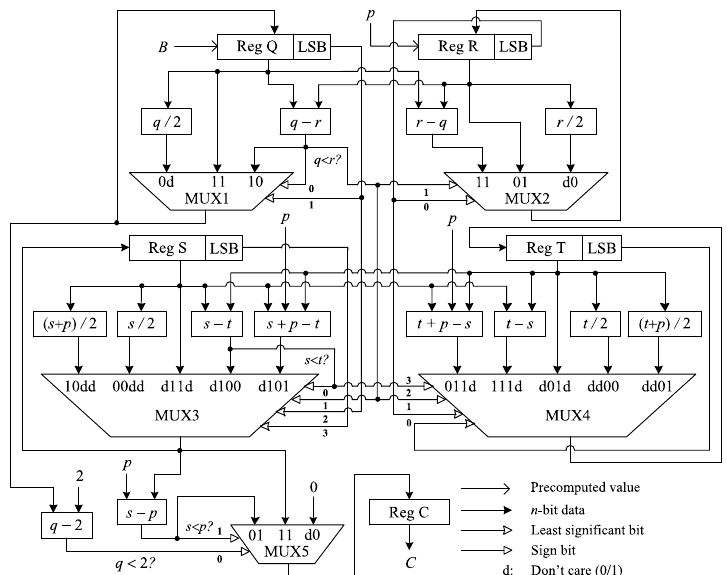
Figure 3. Proposed hardware architecture for modular